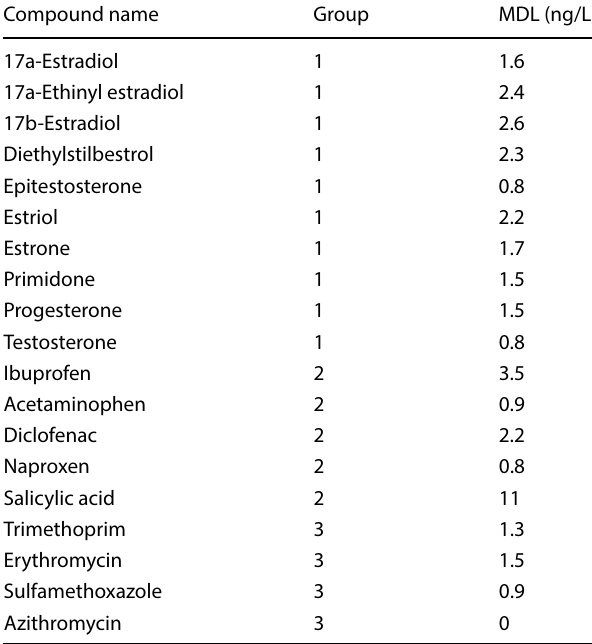
Table 2 The method detection limit (MDL) for